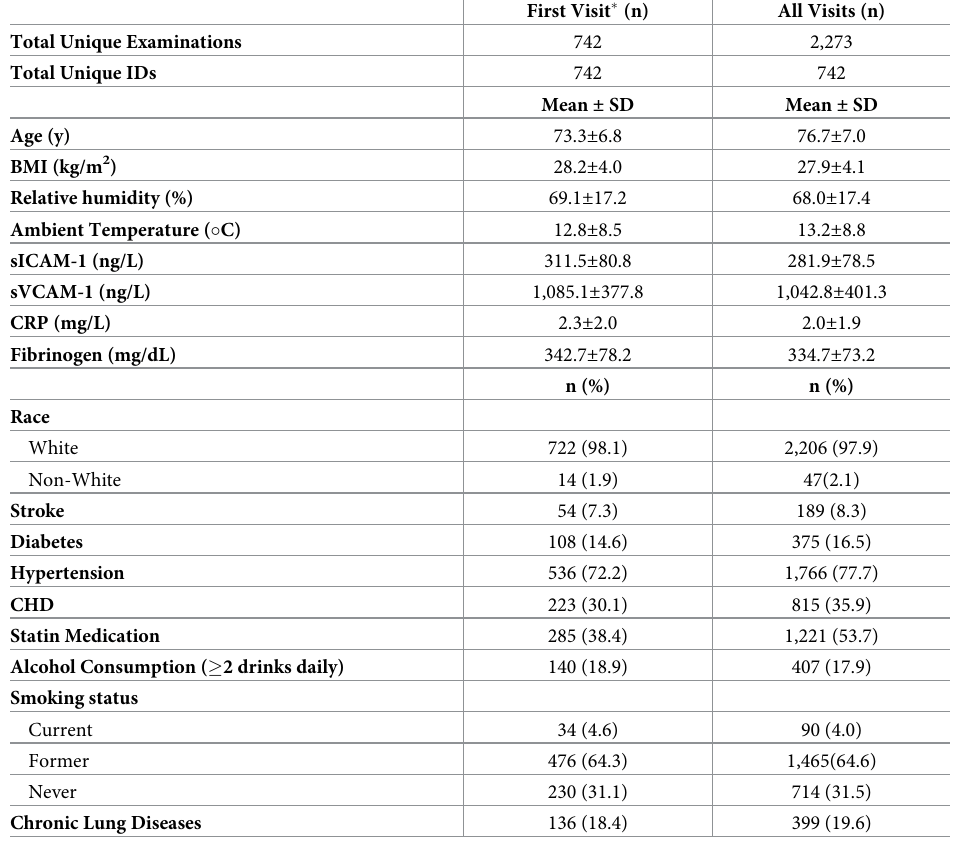
Table 1. Descriptive characteristics of NAS cohort and the weather,